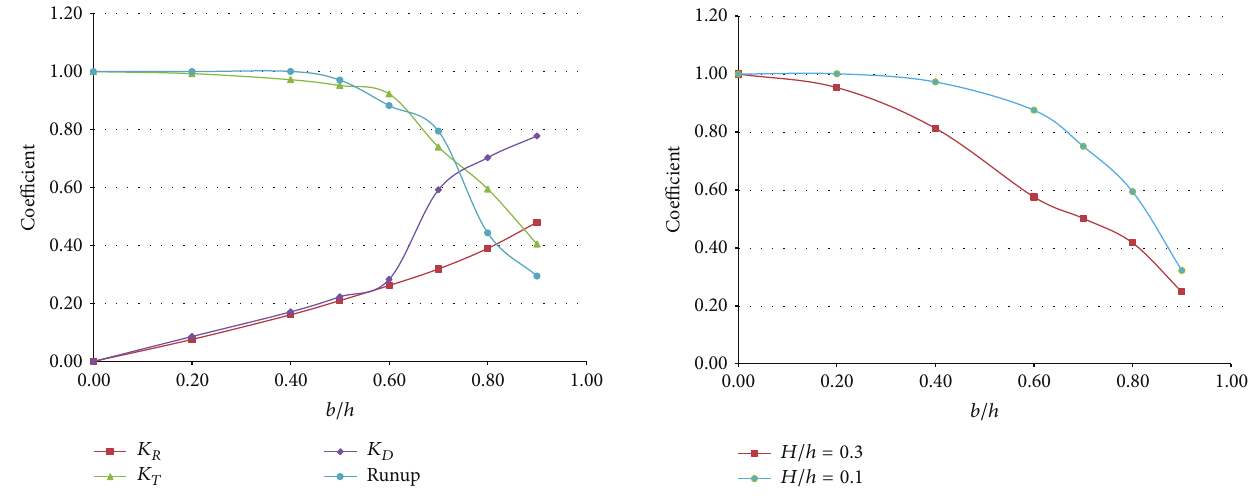
Figure 9: Variation of the coefficients on an inclined beach with a mild slope (𝑠 = 1/20) .